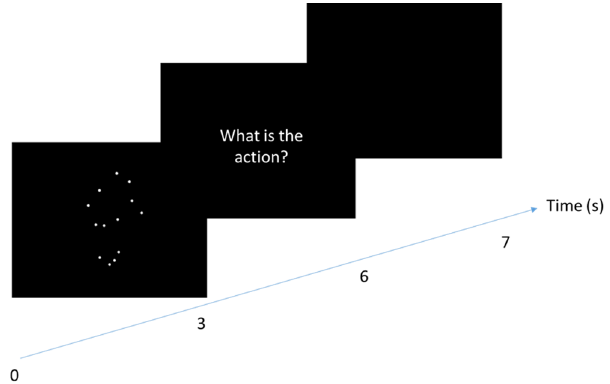
Figure 3. Time course of a trial of the recognition task carried out by both groups in initial and final evaluations. The patients saw a PLD representing an upper or a lower human action (from 1 to 3 s) and they had to name the action perceived. They had 2 s to answer. For each trial, the experimenter noted whether or not the answer was correct.